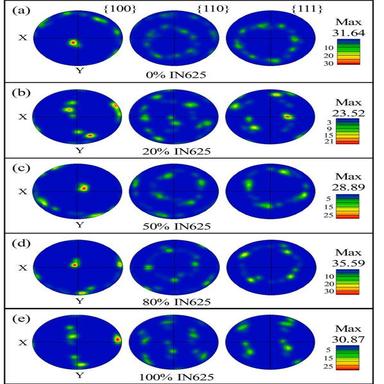
The pole figures of the FGM from 100 wt% SS308L (a) to 100 wt% IN625 (e).